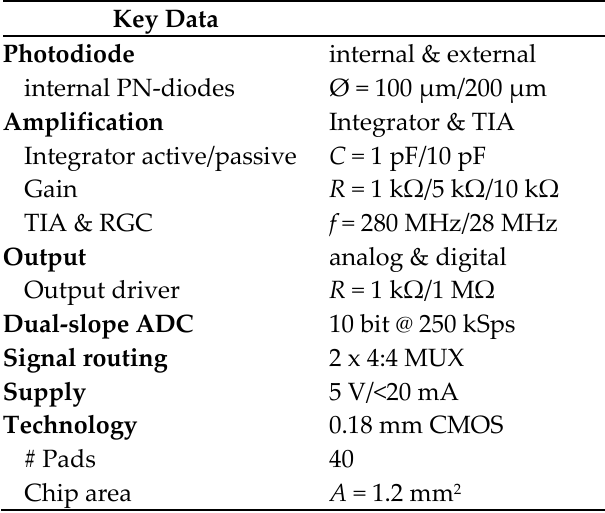
Table 1. Key data of the sensor—simulation